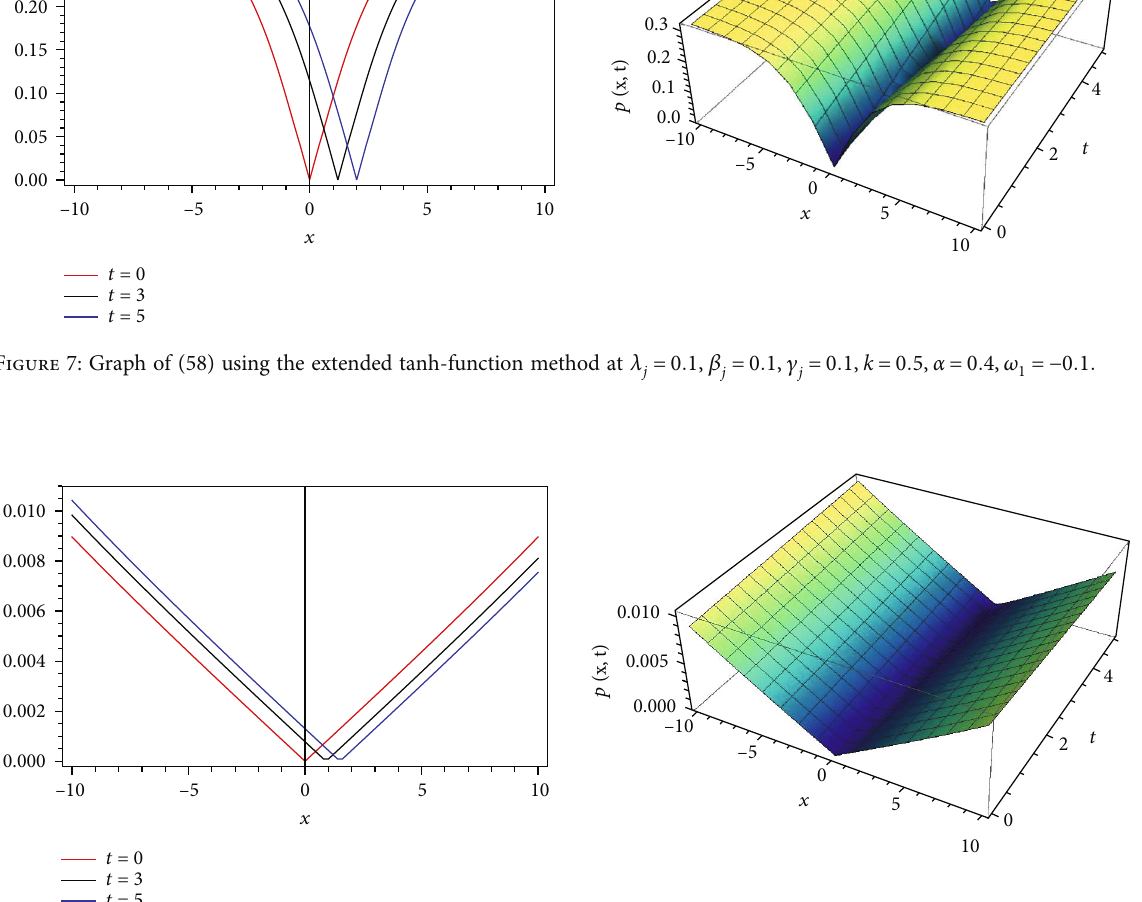
Figure 8: Graph of (47) using the extended tanh-function method at λ